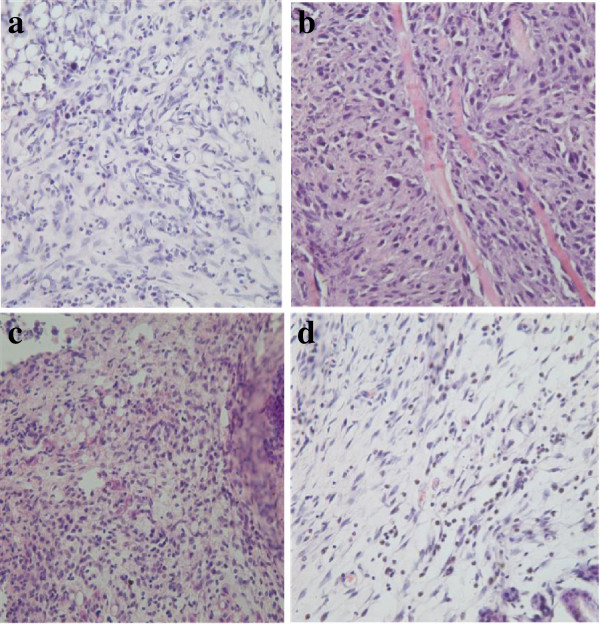
Tumor tissue in HEpathologyat 4 hours after treatment (HE×40). a: Control, b: 131I, c: His-IN, d: 131I-His-IN.